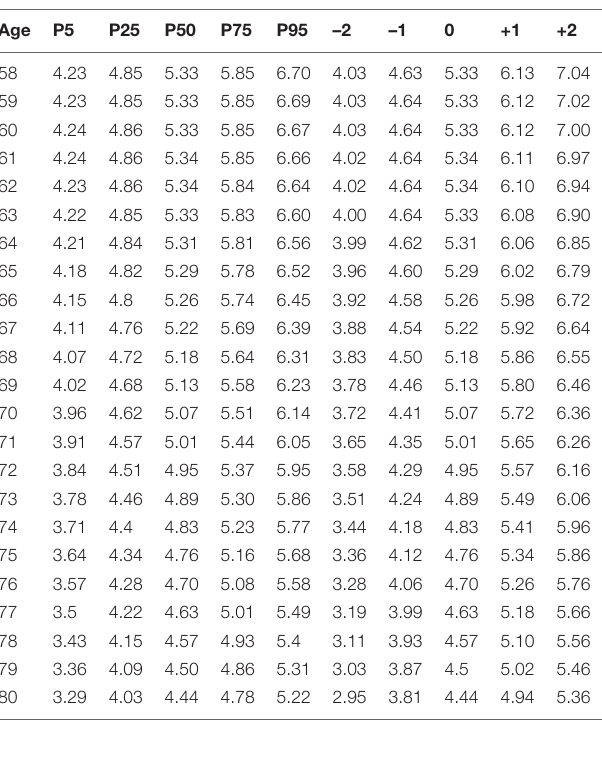
TABLE 3 | Women’s phase angle means estimates and